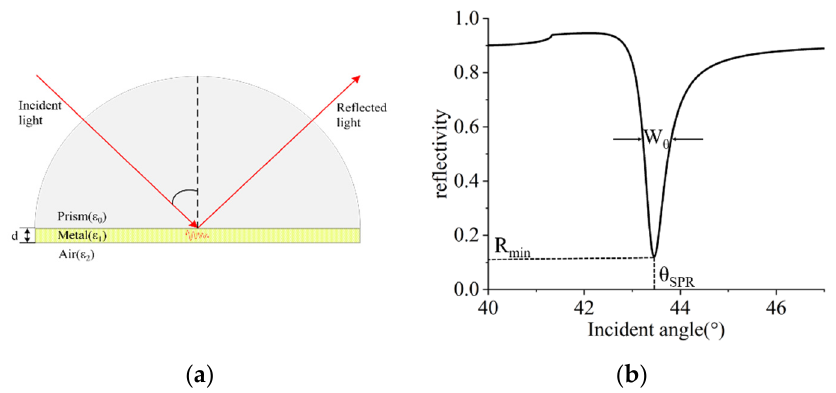
Figure 1. ( a ). A prism–metal–air Kretschmann configuration; ( b ) the reflectivity ( R ) versus the incident angle θ